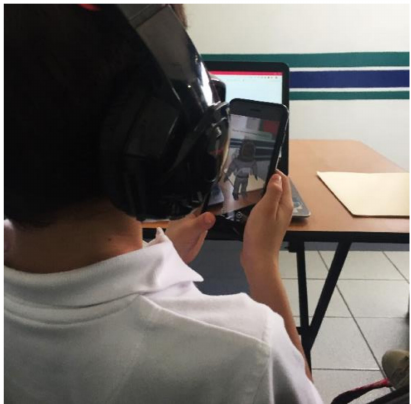
Figure 5. Participant from LowAR group simultaneously observes, interacts and listens during the